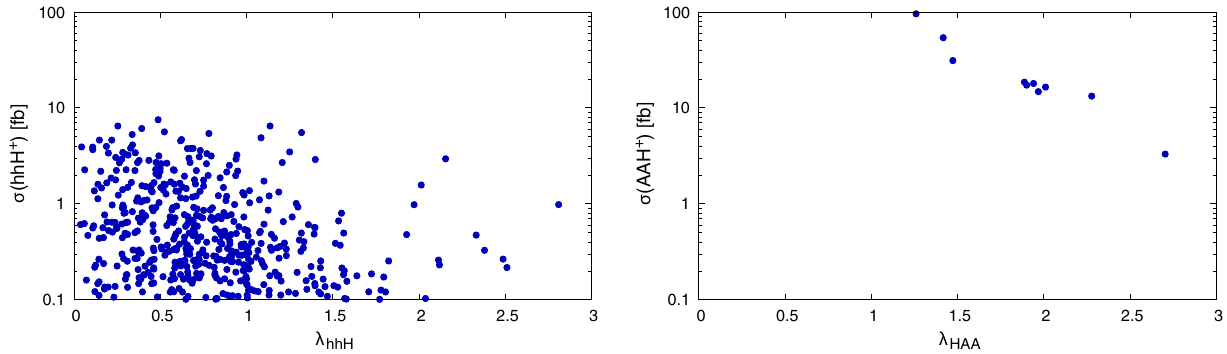
Fig. 8 Cross-sections σ( hhH ± ) and σ( AAH ± ) plottedagainstthetriple-Higgscouplings λ hhH and λ HAA ,respectively,withthecouplings plotted /v . The cross sections are the same as those plotted in Fig. in units of the value of the Higgs triple self-coupling in the SM, 3 m 2 h